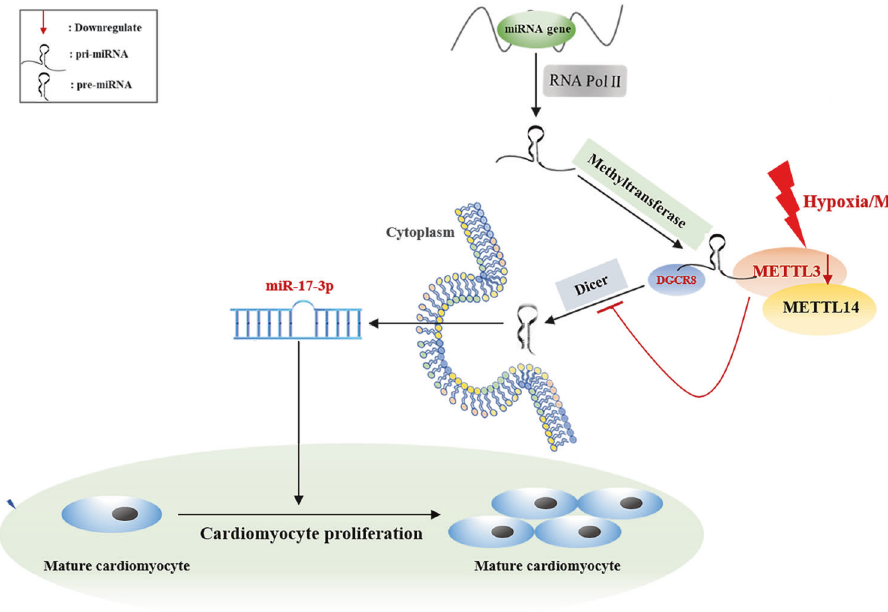
Fig. 8 The summarized Fig. accounting for the potential role of METTL3 in hypoxia-exposed neonatal cardiomyocyte. The possible molecular mechanisms for the potential role of METTL3 in hypoxia-exposed neonatal cardiomyocyte: METTL3 may improve cardiomyocyte proliferation under hypoxic environment by upregulating proliferation-related miR-17-3p in a DGCR8-dependent pri-miRNA-processing